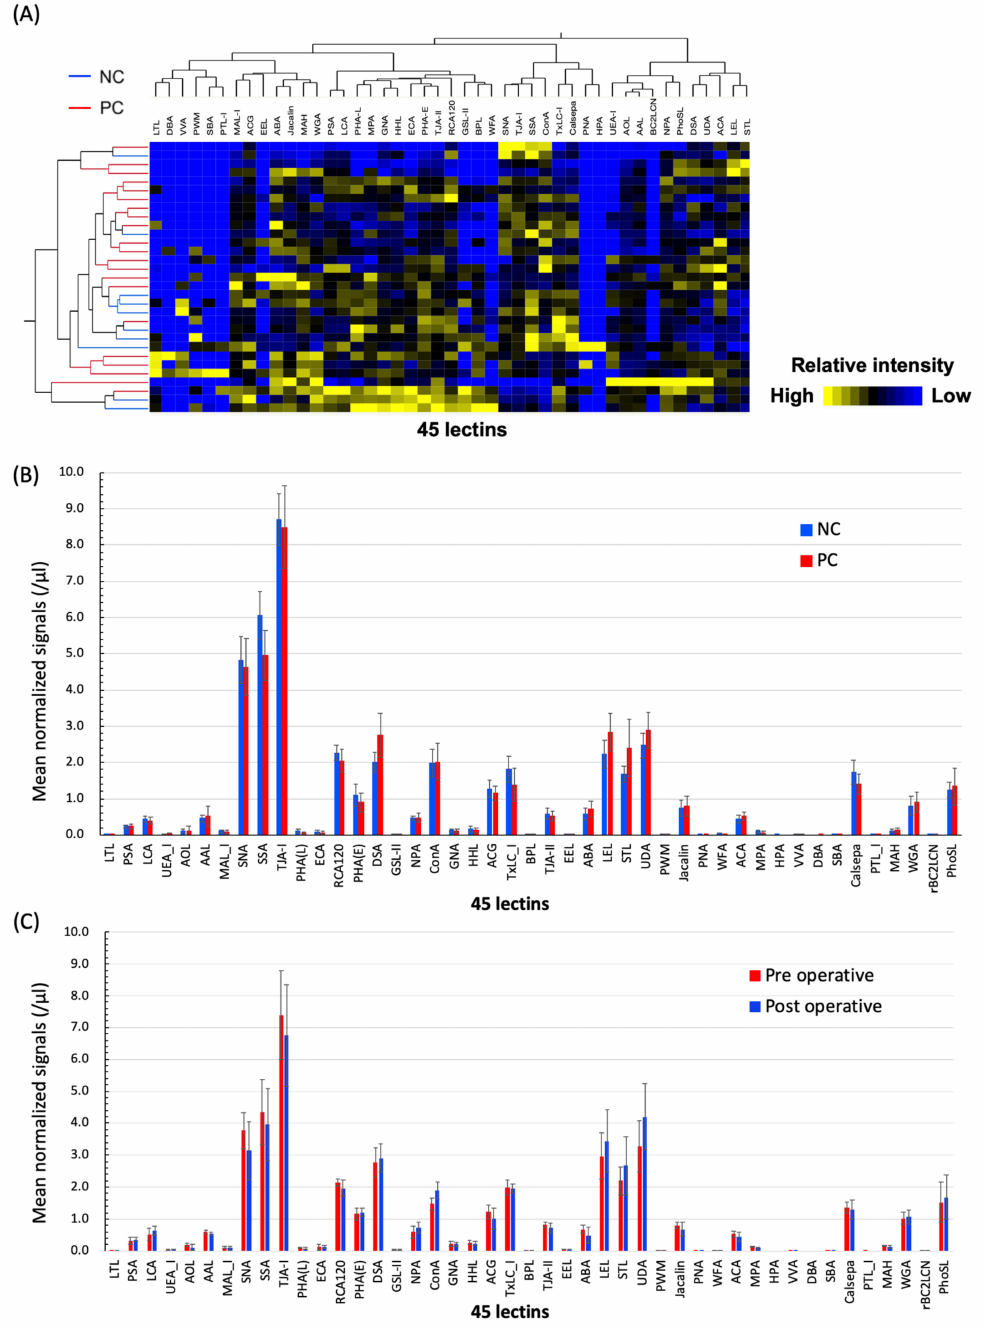
Figure 2. Glycomic profiling of the EVs in PC sera by lectin microarray analysis. EVs in PC ( n = 21) or NC ( n = 10) sera were isolated with the Magcapture Exosome Isolation Kit and then labeled with Cy3-succimidyl ester. The labeled EVs were analyzed with lectin microarray immobilized with 45 lectins. ( A ) Hierarchical clustering analysis was performed using the glycomic profiling data of PC compared to that of NC. The heat map shows a two-way cluster analysis carried out on the data of the serum. The lectin signal levels are indicated by color changes from yellow (high expression level) to blue (low expression level). ( B ) Comparison of the mean normalized signal of the 45 lectins between PC and NC. The NC and PC patients are indicated by blue and red, respectively. ( C ) Comparison of the mean normalized signal of the 45 lectins between pre- and post-operative sera. The pre- and post-operative sera are indicated by red and blue, respectively. Data are the means ± S.E. NC, normal controls; PC, pancreatic cancer; EV, extracellular